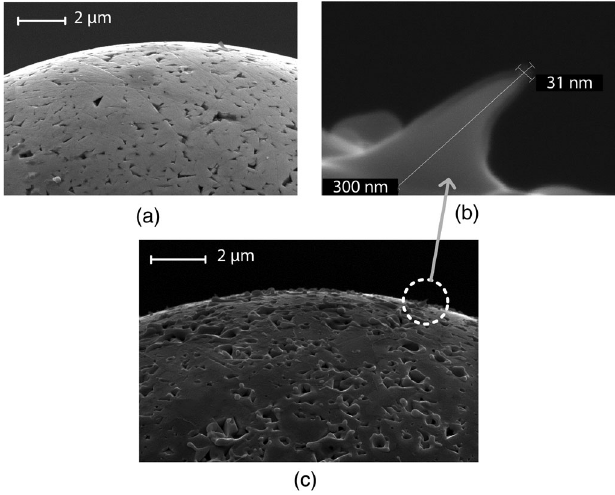
FIG. 2. SEM images of the tungsten carbide cathode (a) virgin cathode (b) submicron sized tip (c) cathode after